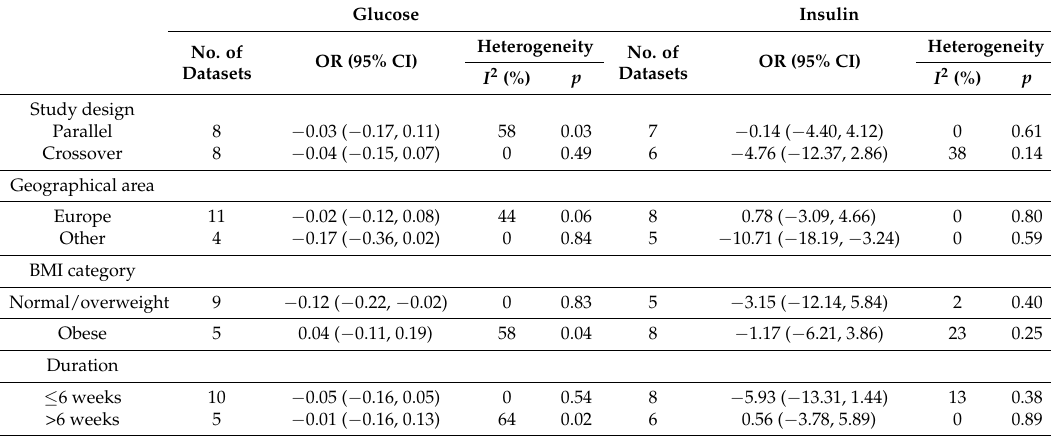
Table 2. Subgroup analyses of medium- and long-term wholegrain intake effect on fasting glucose and insulin. Glucose